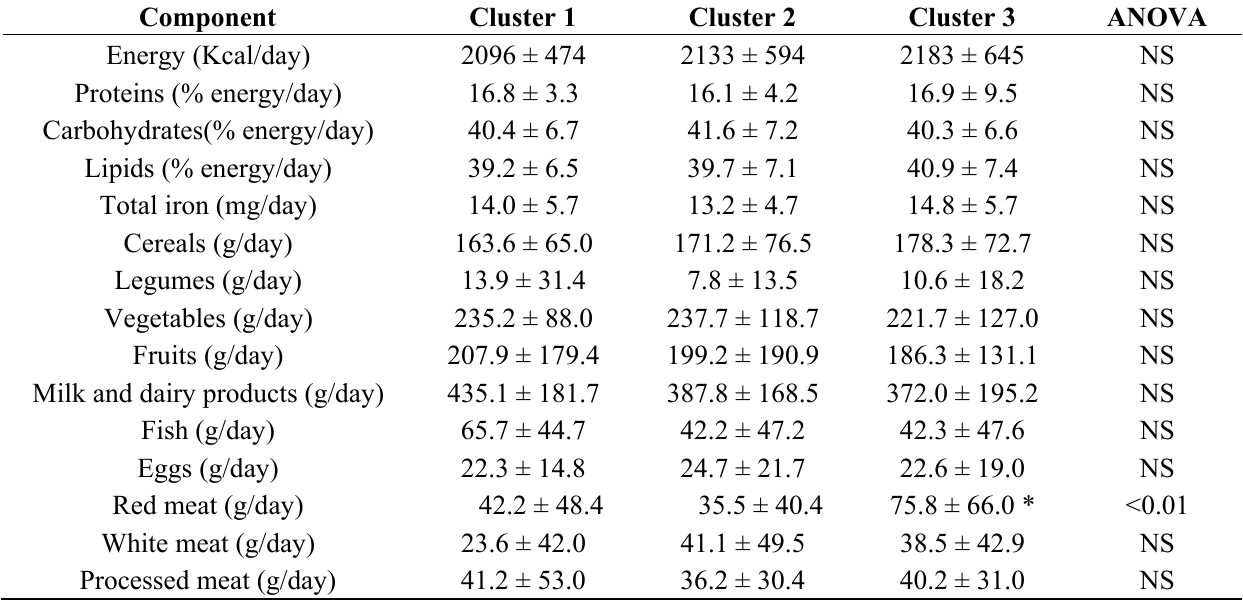
Table 2. Energy, total iron and food groups intakes according to the